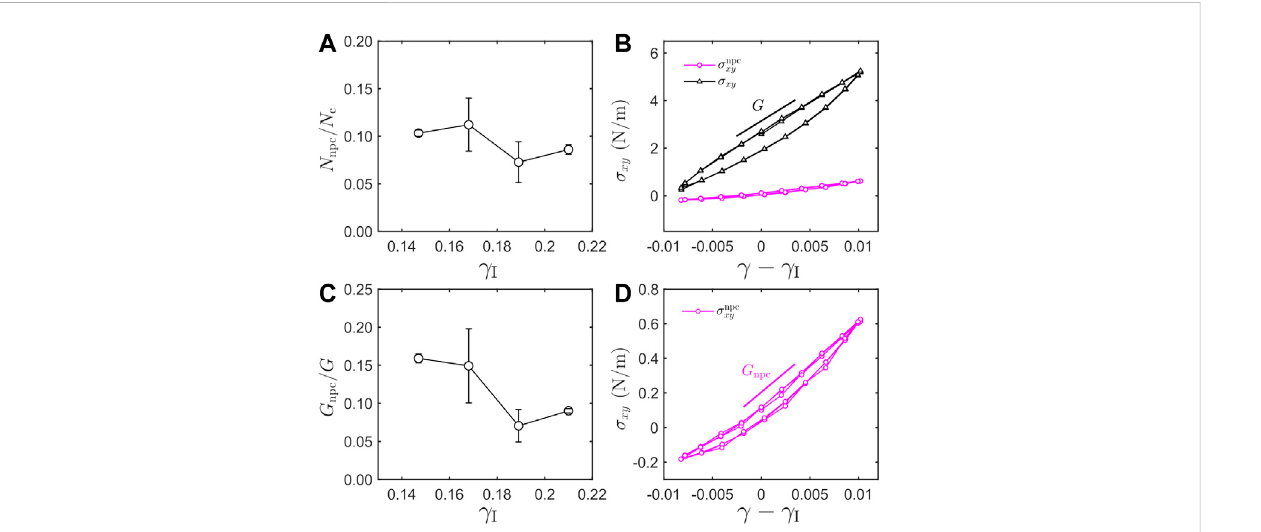
FIGURE 5 Statistics of the non-persistent contacts and their contributions to the emergent shear modulus. (A) The fraction of non-persistent contacts, de fi ned as the number of non-persistent contacts divided by the total number of contacts, plotted for ultrastable states formed under same δγ =0.95%butdifferentinitialstrains γ I .Errorbarsarestandarddeviationscomputed frommultipleultrastablestateswithsame contributed from all contacts, σ xy , and the shear stress only from the non-persistent contacts, σ npc xy for an ultrastable state under three consecutive shear cycles. (C) The ratio between G npc and G calculated from ultrastable states with same δγ =0.95% but different γ I . Error bars are standard deviations computed from multiple ultrastable states with same γ I . (D) shows a zoom-in to the purple curve ( σ npc xy ) in (B)